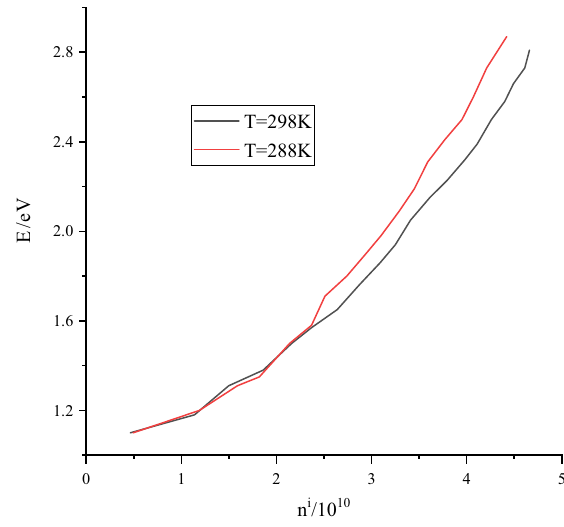
Figure 2: The in fl uence of light energy E on the number of carriers n i at di ff erent temperatures.